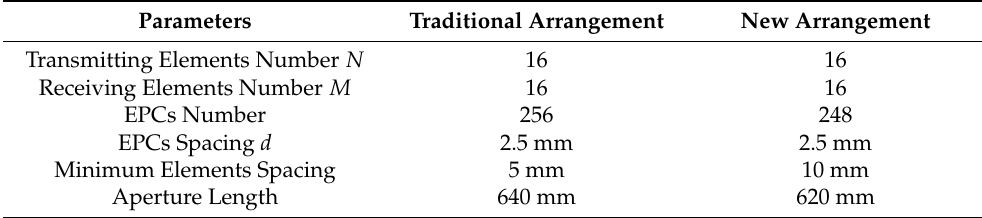
Table 1. Comparison of two arrangement parameters.